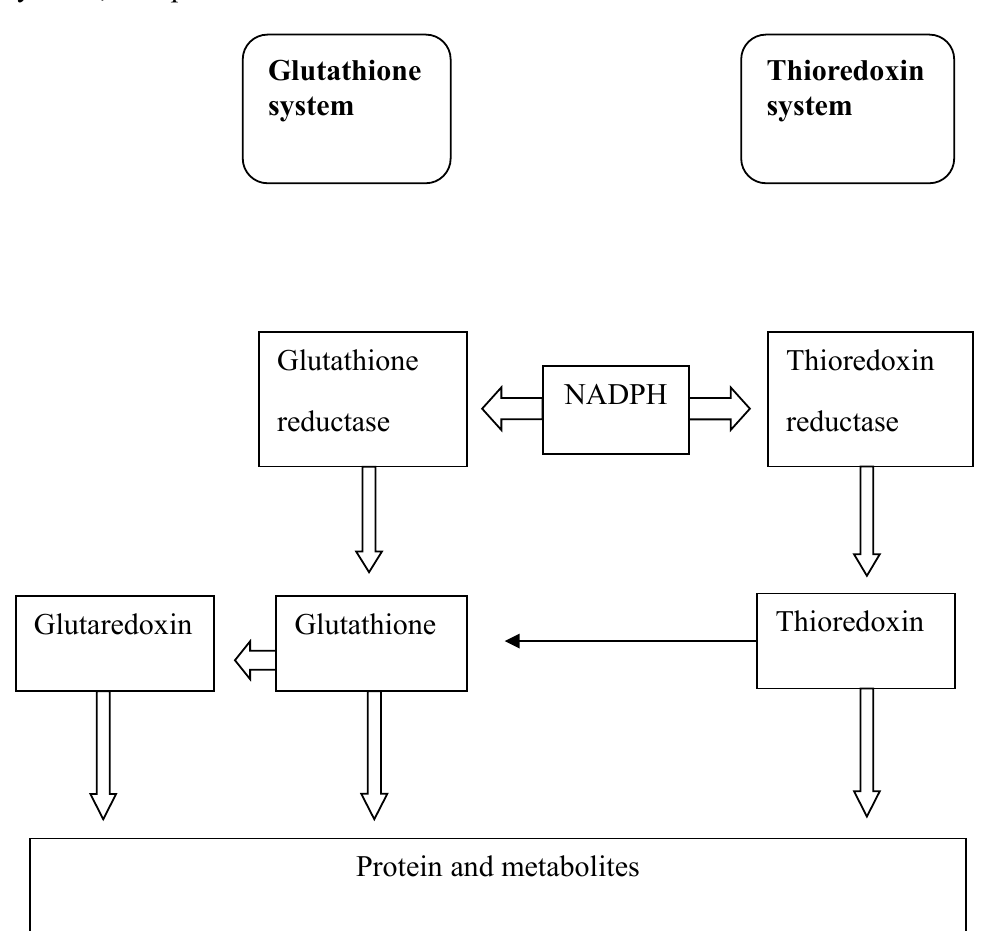
Figure 4. The similarities between glutathione and thioredoxin systems. The activity of both systems, is dependent on the electron donor